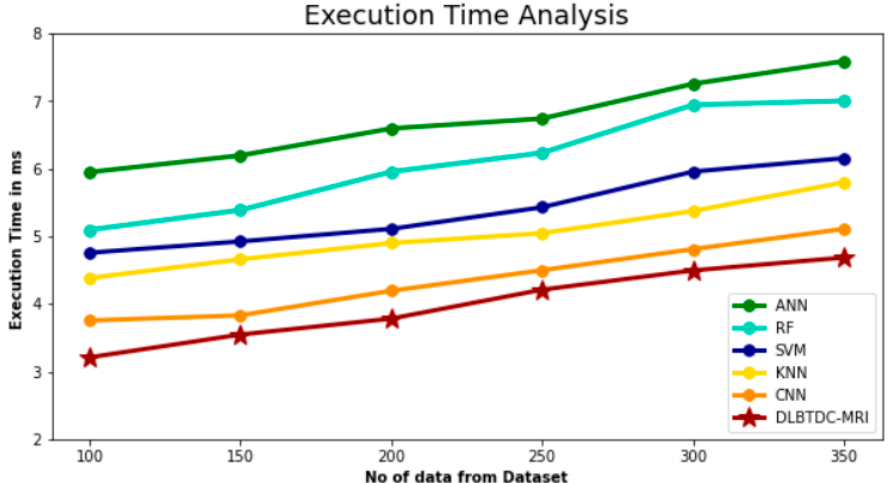
Figure 9. Execution time analysis of DLBTDC-MRI method with existing Figure 8. Execution time analysis of DLBTDC-MRI method with existing system.